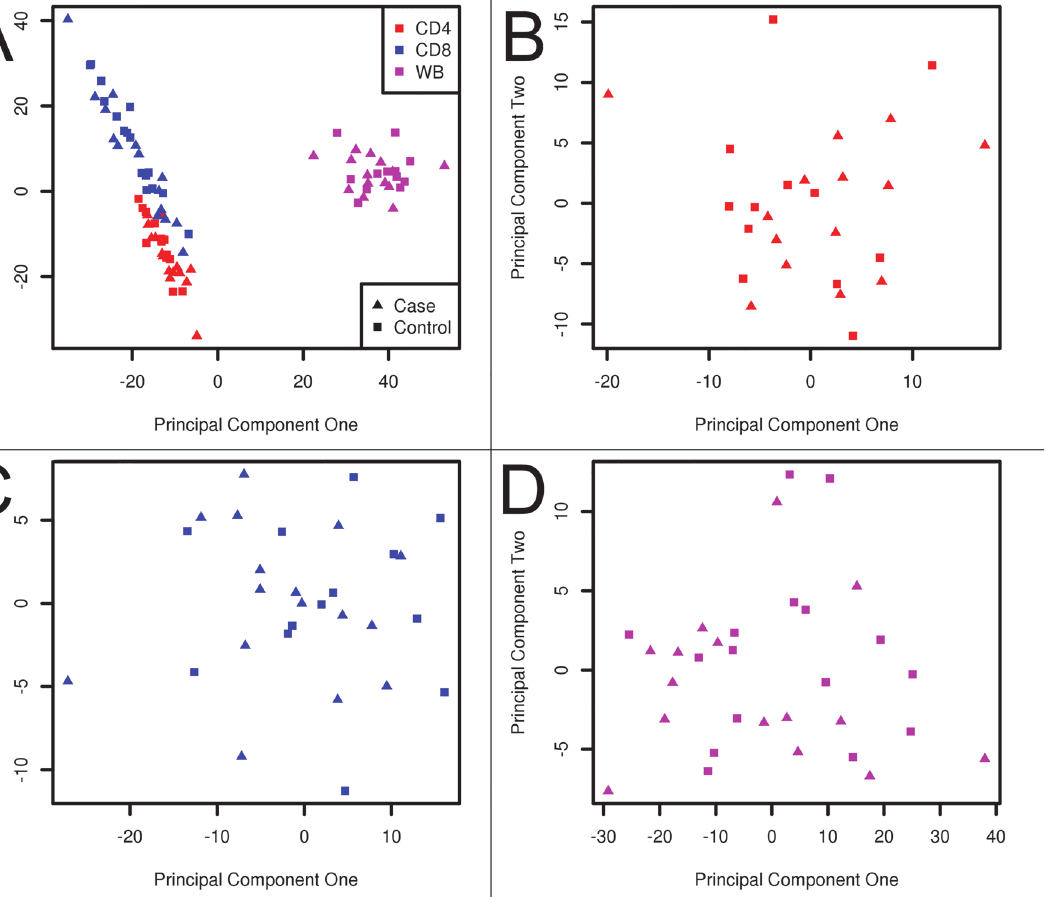
Fig 1. Principal component analyses. For samples in analyses a PCA was performed on overall methylation levels of CpG-sites that passed both quality controls and SNP filtering in ( A ) whole blood (Red), CD4+ T cells (Blue) and CD8+ T cells (Magenta) for all cases (squares) and controls (triangles). ( B ) PCA of DNA methylation data from whole blood only. ( C ) PCA of DNA methylation data from CD4+ T cells only. ( D ) PCA of DNA methylation data from CD8+ T cells only.